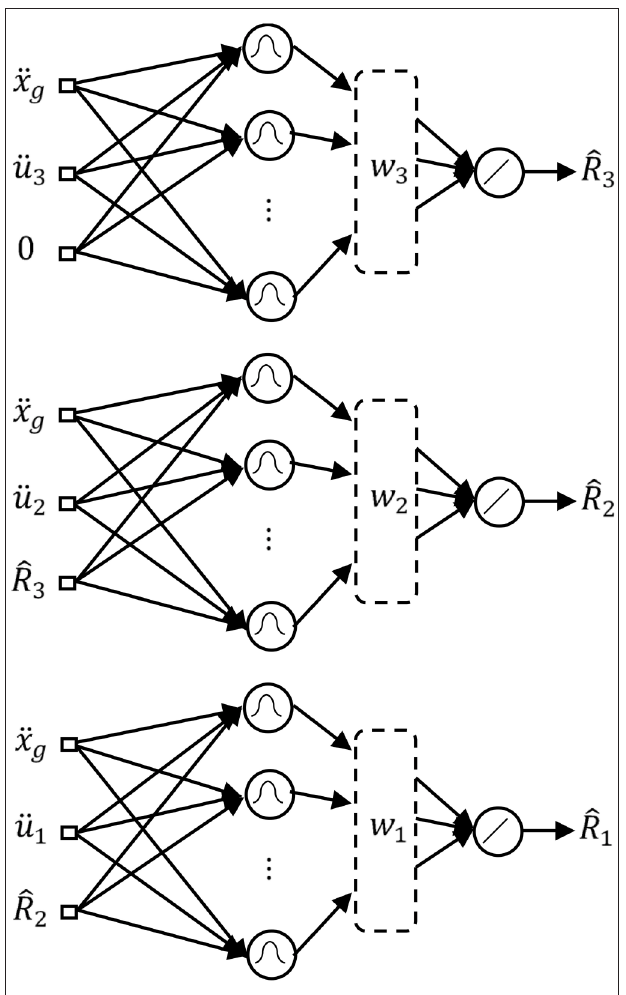
FIGURE 6 | TMCMC based system identification